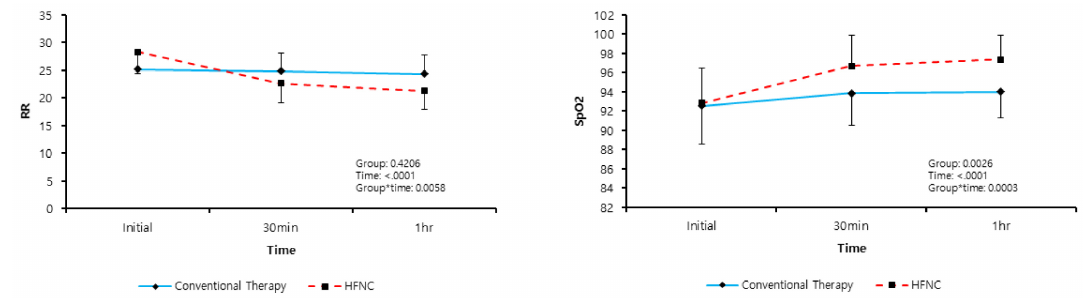
Figure 2. Linear mixed model of changes in respiratory rates (RR) and pulse oximetry (SpO 2 ). The graphs show interaction effects between time and treated group using the linear mixed model (Group * Time). HFNC: high-flow nasal cannula.